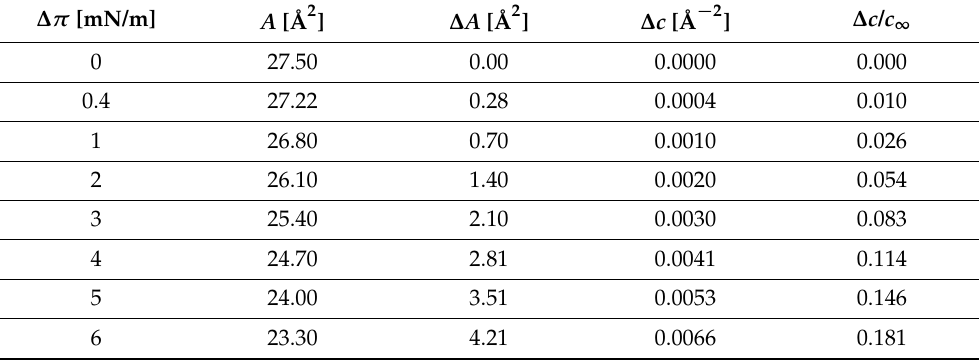
Table A1. The measured molecular area A of erucic acid in the coexistence regime (cf. Figure 1), ∆ A = A − A ∞ , the supersaturation ∆ c (calculated with Equation (A2)) and the normalized super- saturation ∆ c / c ∞ (calculated from Equation (A6)), for an excess lateral pressure ∆ π = π − π ∞